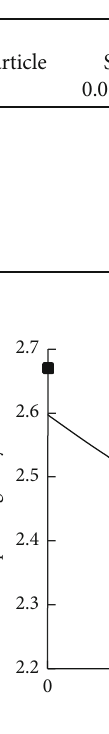
Figure 5: The curve of particle analysis under di ff erent hydroxyl aluminum